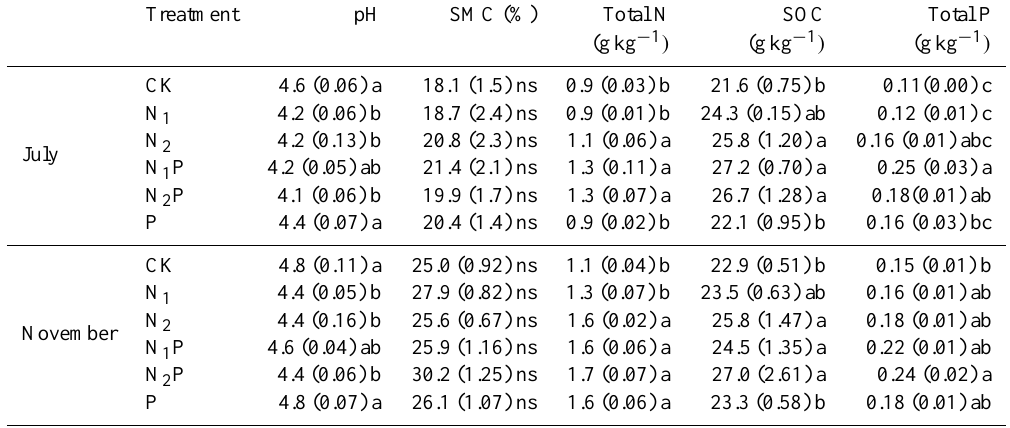
Table 1. Response of soil properties to N and P additions to Chinese fir plantations in July and November (means ± standard errors). Treatment pH